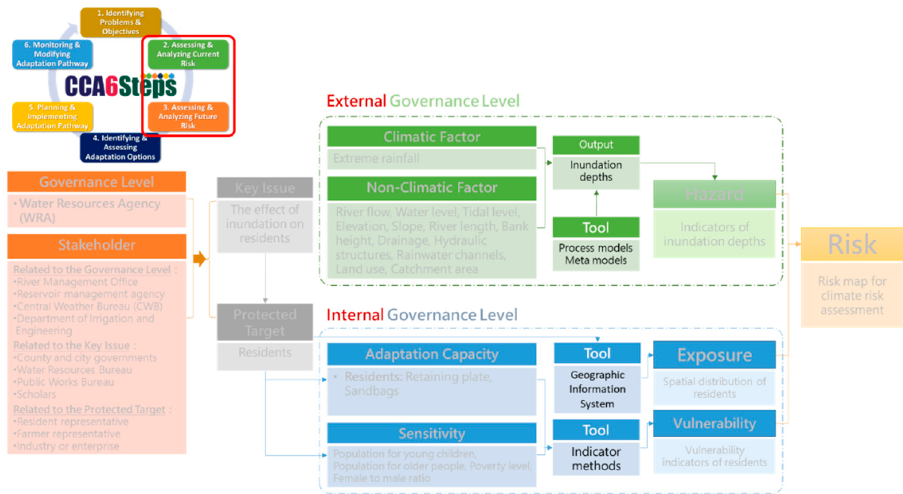
Figure 8. The proposed algorithm of climate risk assessment for presenting tools and indicators based on Steps 2 and 3 of CCA6Steps.